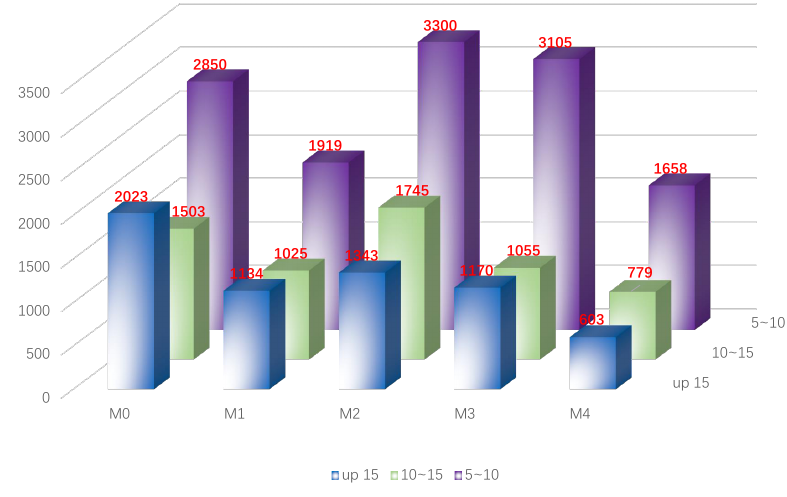
Figure 6. Distribution of M stars of